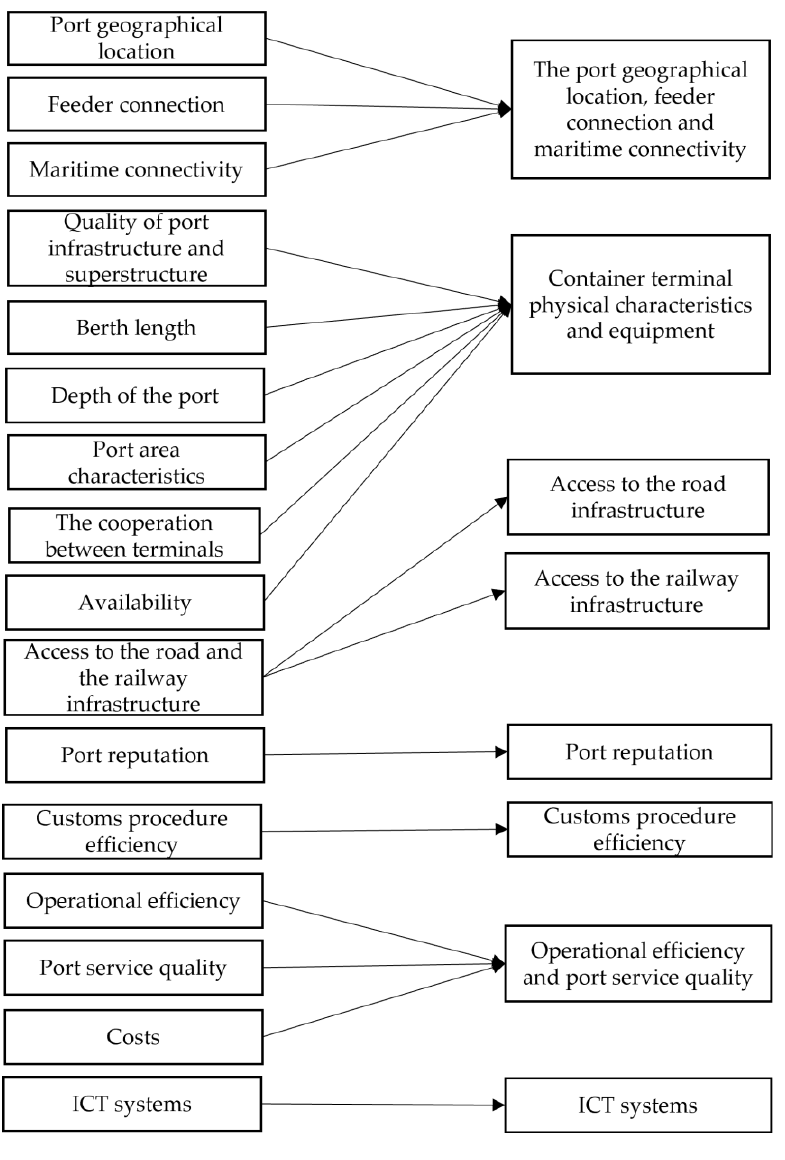
Figure 2. Factor groups.